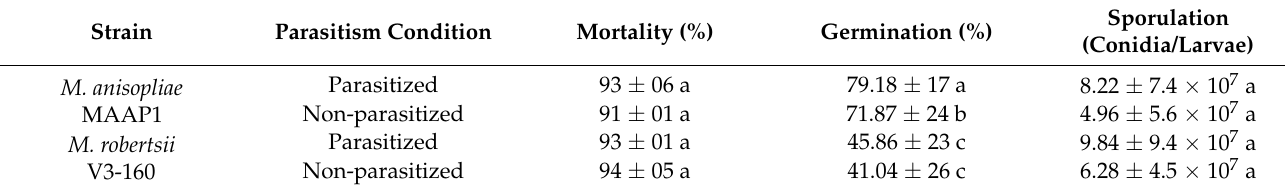
Table 1. Mortality (Abbott correction % values), and germination and sporulation rates ( ± SD) of Metarhizium robertsii V3-160 and Metarhizium anisopliae MAAP1 from Anastrepha ludens larvae parasitized or non-parasitized by Diachasmimorpha longicaudata .